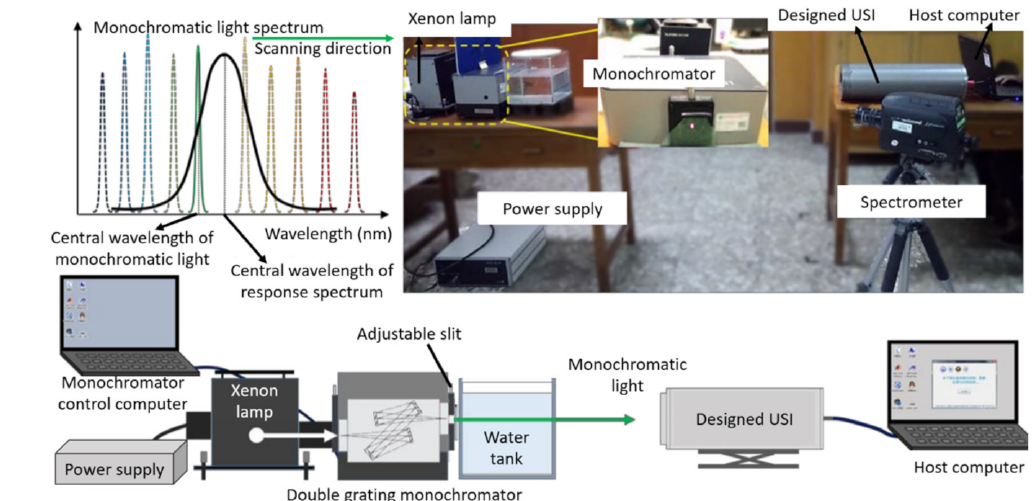
Figure 2. Setup and illustration for spectral resolution calibration of the designed USI system. A xenon light source (7ILX150C, SaiFan photoelectricity, China), a double-grating monochromator (7ISU151, SaiFan photoelectricity, China), a spectral radiometer (PR715, JADAK, North Syracuse, NY, USA), and a high-resolution fiber spectrometer (HR400, Ocean Insight, Orlando, FL, USA) are used in the experiment.